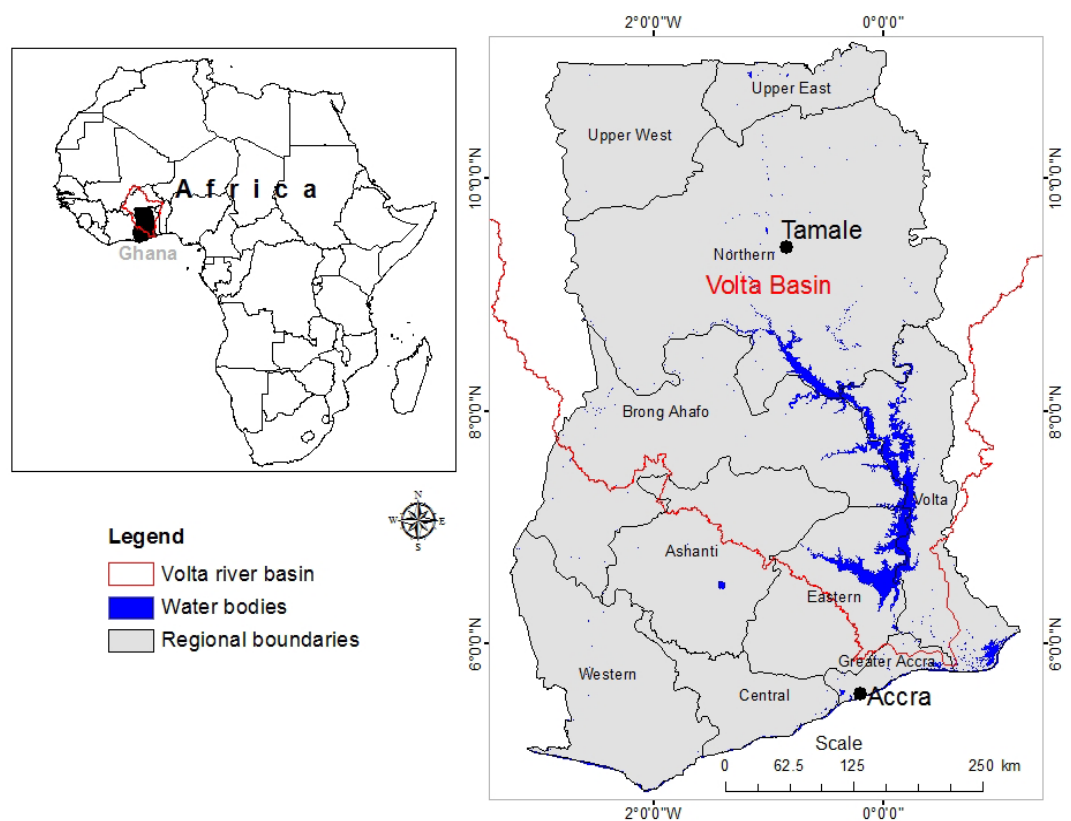
Figure 1. Study area of Ghana, West Africa, with regions. The figure shows the Volta Basin with provinces. (River basin derived from SRTM 90 m